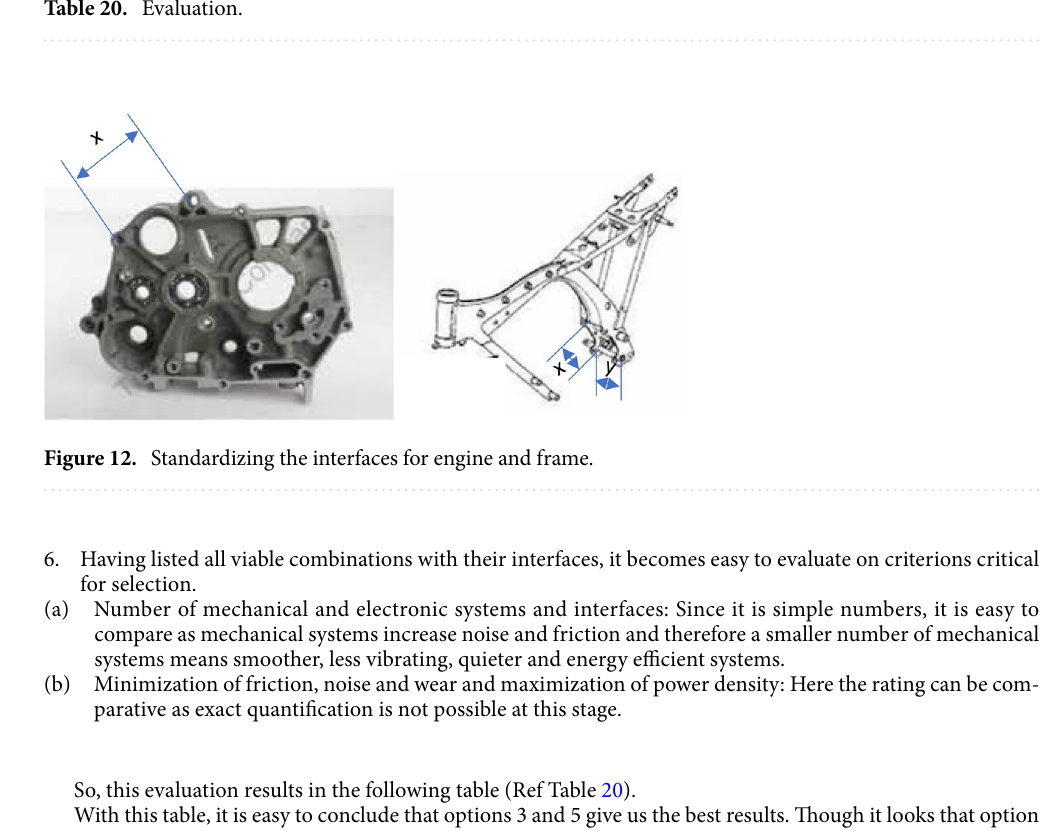
Table 20. Evaluation.